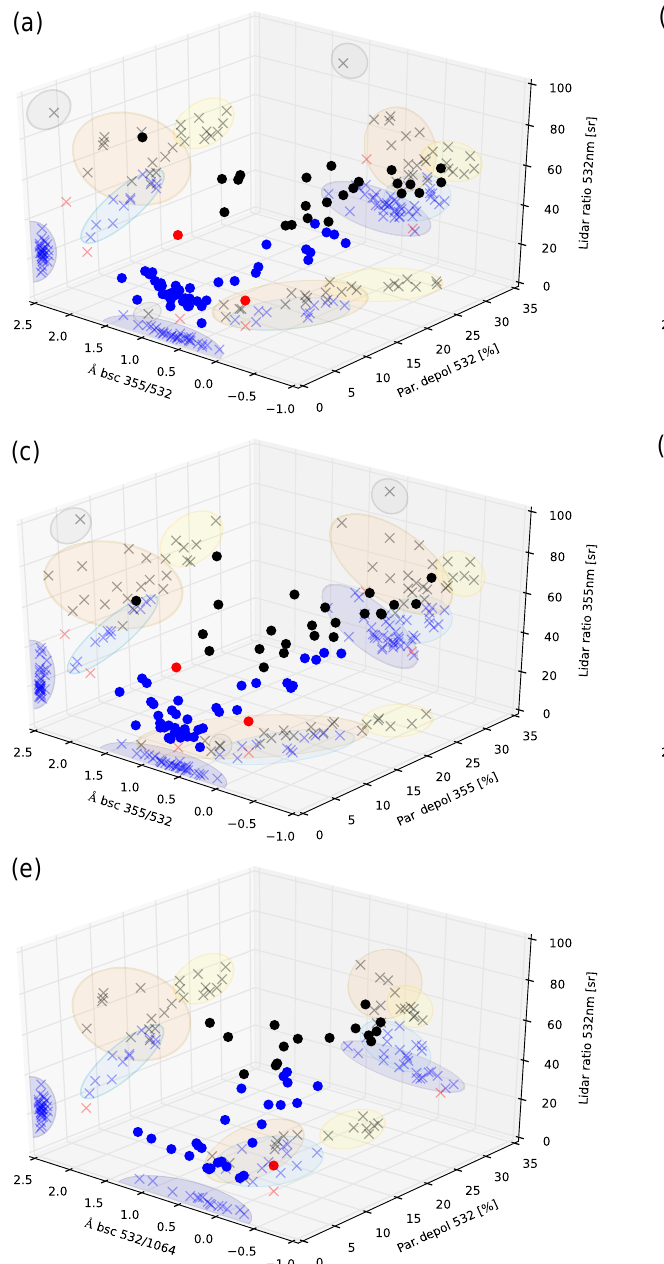
Figure 15. Three-dimensional illustration of the relation between lidar ratio, depolarisation ratio, and backscatter and extinction-related Ångström exponent. Blue dots represent MBL measurements, black dots elevated aerosol layers, and red dots dried marine layers. Coloured ellipses denote the different aerosol categories as in Fig.